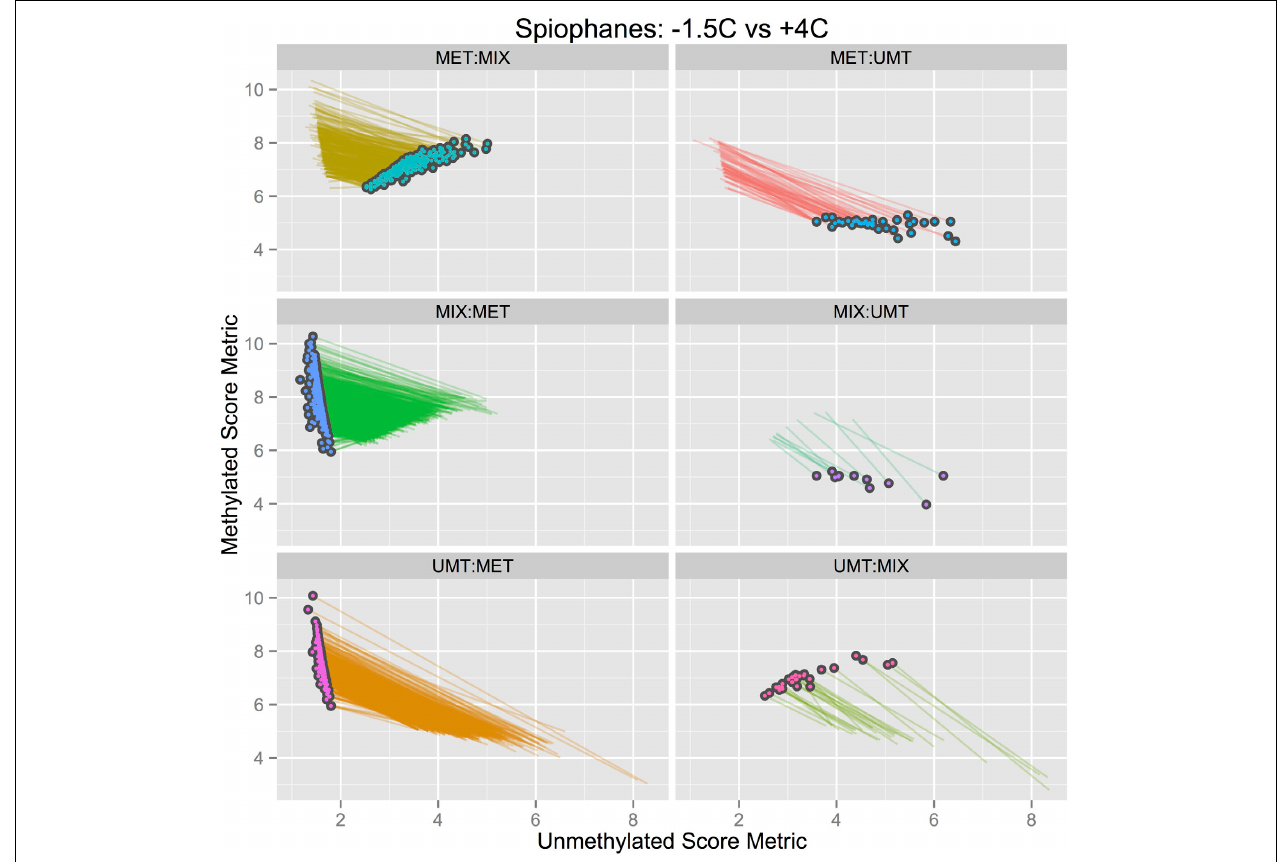
FIGURE 5 | Total methylation dynamics. Data for each CpG site in Figures 3 , 4 are now linked by a line and separated into six shifts (each panel) to reveal the pattern of shifts identified in the experiment. Each point on the plot represents a single CpG site that has evidenced a change in methylation